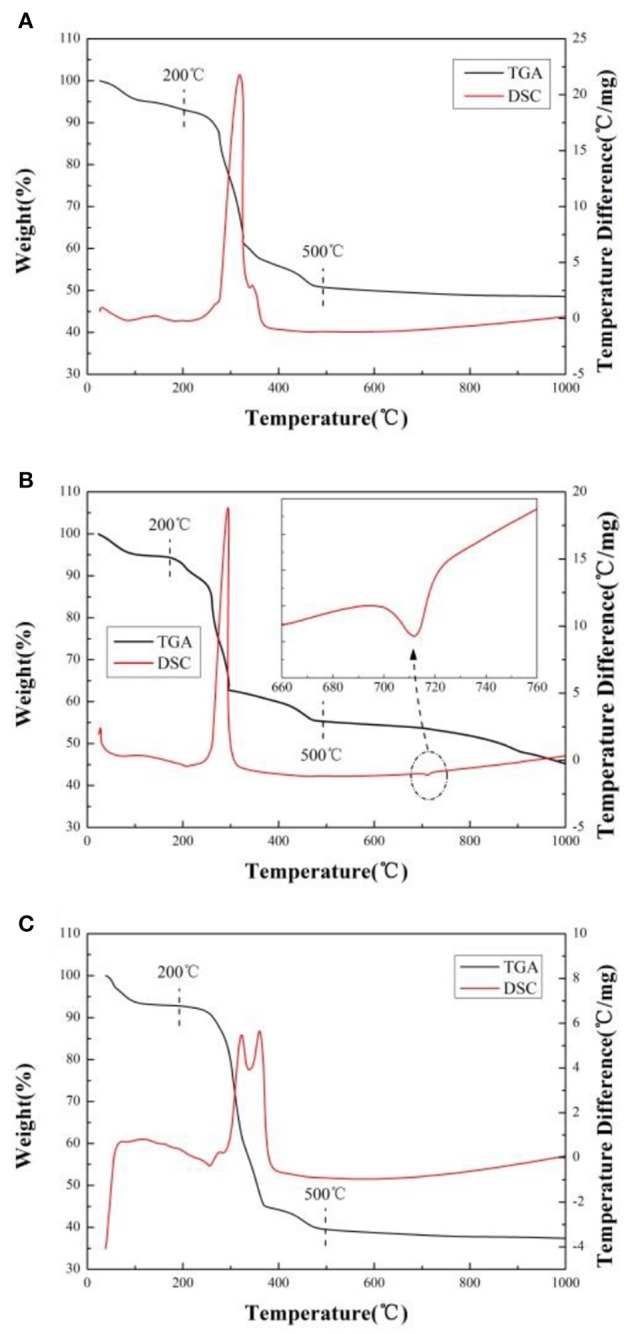
TG-DSC curves of the precursor by using different lithium sources. (A) LiOH·H2O, (B) Li2CO3, (C) CH3COOLi·2H2O.